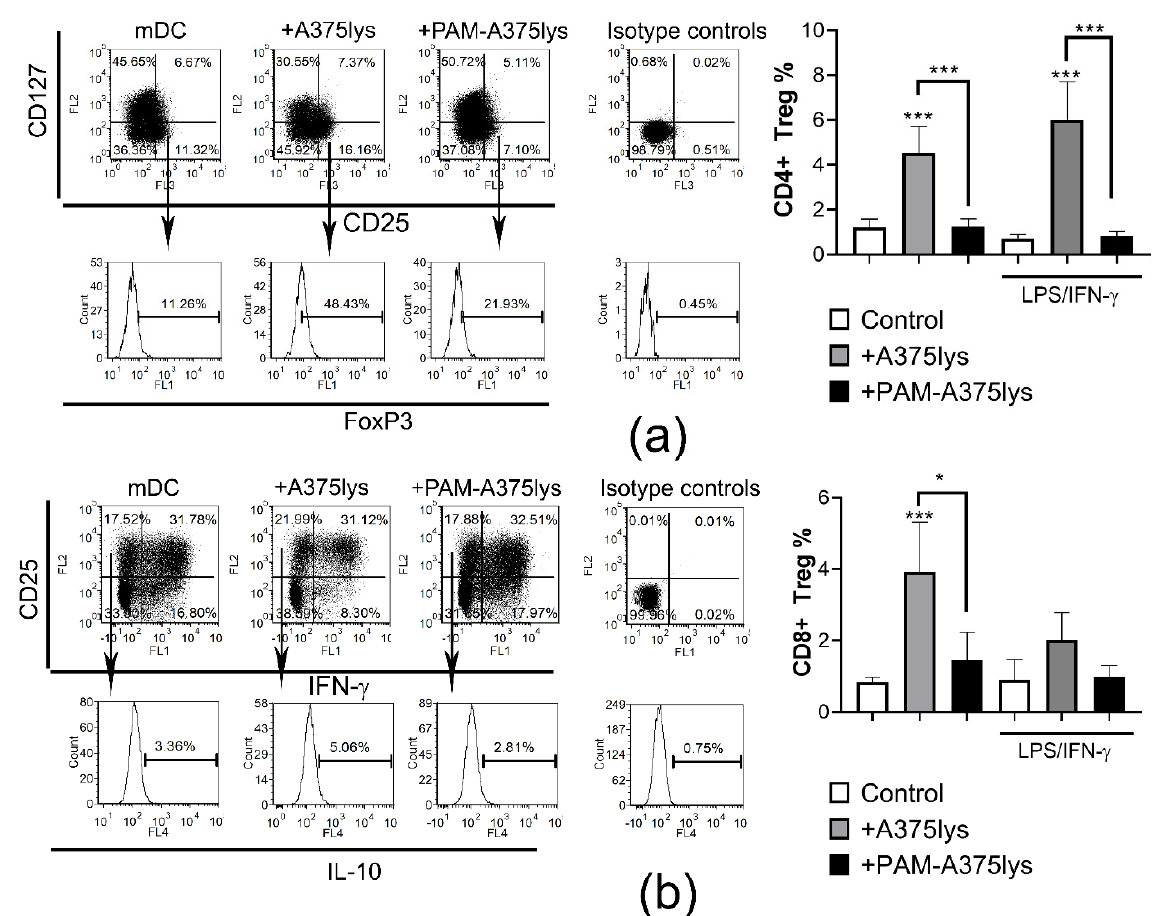
Figure 7. Treg induction capacity of DCs treated with A375 lysates. DCs either treated or not with the A375 lysate (+A375lys) or the PAM-treated A375 lysate (+PAM-A375lys) were co-cultivated with MACS-purified allogeneic T cells (1 × 10 5 /well) at 1:40 (DC: T cell ratio) for 5 days, in the presence of 2 ng/mL of IL-2, followed by the stimulation of the co-cultures with PMA/ Ca Ionophore/ Monensin for the last 3 h prior to their staining for flow cytometry. ( a ) Representative dot-plots are shown on total gated CD4 + T cells after staining to CD25, CD127 and intracellular FoxP3. The summarized results on the % of CD4 Tregs are shown as % ± SD of 3 independent experiments. ( b ) Representative dot-plots are shown on total gated CD8 + T cells after staining to CD25, and intracellular IFN- γ and IL-10. The summarized results on the % of CD8 Tregs are shown as % ± SD of 3 independent experiments. * p < 0.05, ** p < 0.01, *** p < 0.005 vs. corresponding control DCs (white bars) or as indicated with lines (RM-ANOVA, Tukey’s multiple comparison test). Statistical significance between the corresponding iDCs and mDCs was not indicated for clarity.